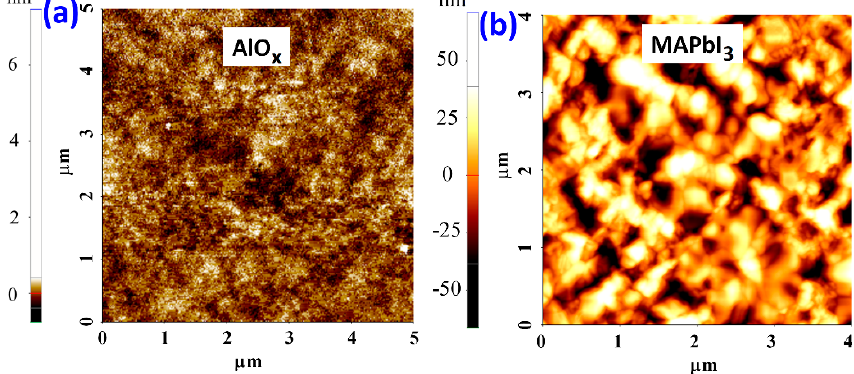
Figure 4. Atomic force microscope (AFM) images of the ( a ) AlO x and ( b ) MAPbI 3 layer (MAI / PbI 2 = 1.0) solution processed in ambient air.